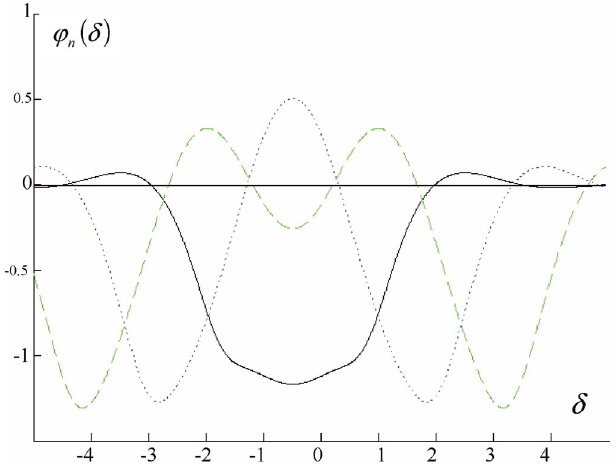
(cid:3) (cid:28) (cid:4) for the first three modes at L (cid:1) FIG. 3. (Color) Function ’ n 2 : 5 . The black line corresponds to n (cid:1) 1 , the blue line to n (cid:1) 2 , and the green line to n (cid:1) 3